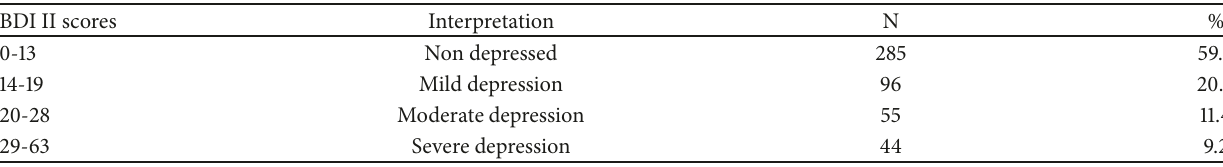
Table 3: Summary of BDI II scores and their